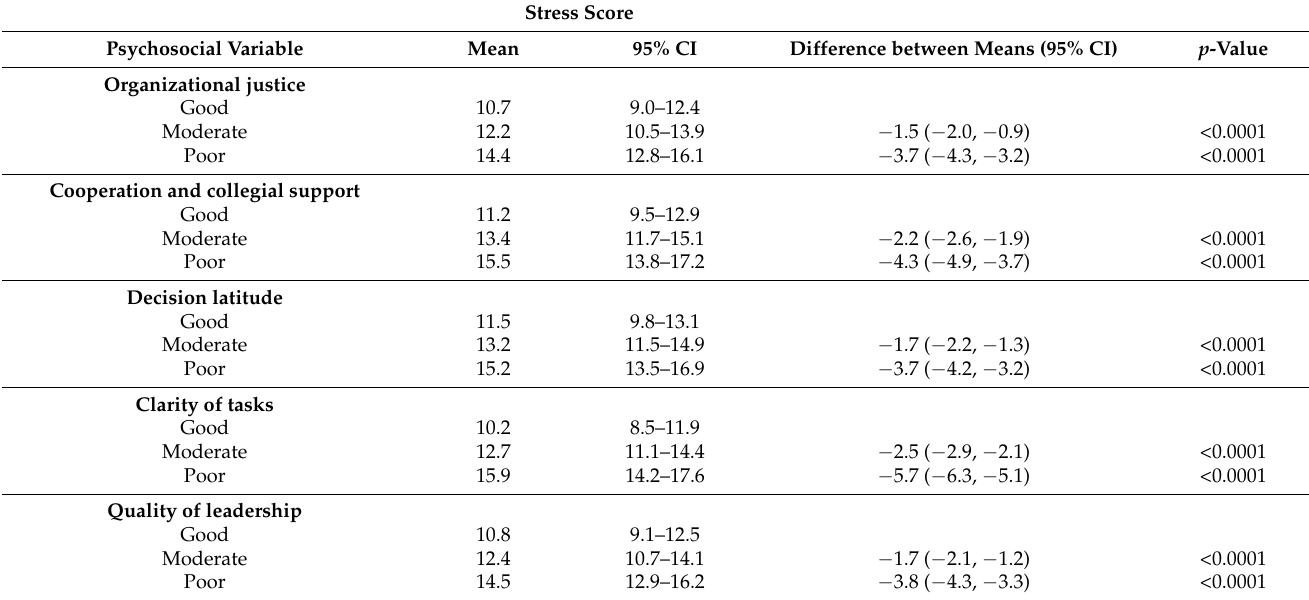
Table 2. Model 1. Individually adjusted psychosocial variables and stress scores